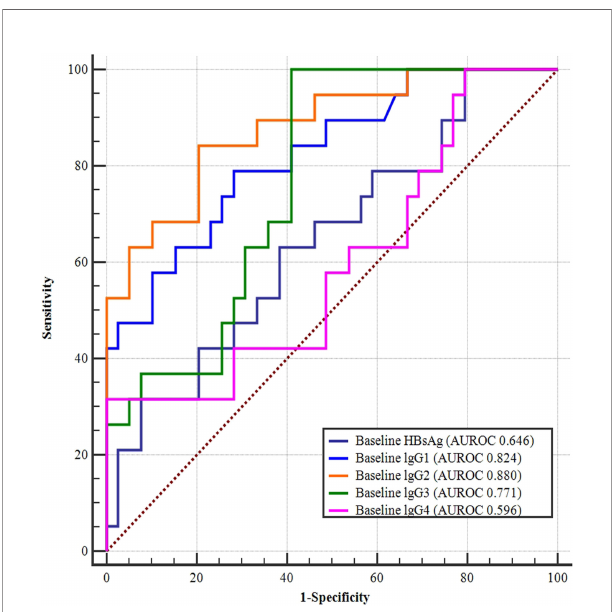
FIGURE 4 | ROC curves at week 12 HBsAg, and week 12 HBsAg changes from baseline, week 12 IgG1, IgG2, IgG3, and IgG4 for predicting HBsAg clearance. The largest area under the curve was week 12 lgG3 (AUROC 0.867), followed by week 12 IgG1 (AUROC 0.852), week 12 lgG2 (AUROC